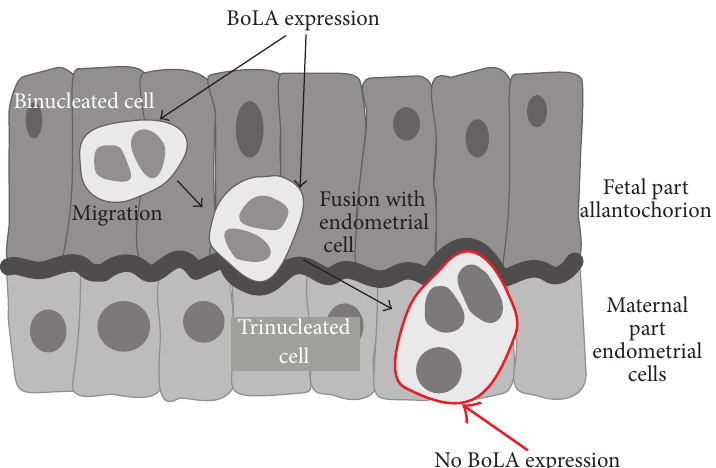
Figure 2: Expression of classical MHC I (BoLA) proteins in the cow placenta. Classical BoLA are expressed only on migrating binuclear cells and they disappear when binuclear cells fuse with endometrial cells (creating trinucleated